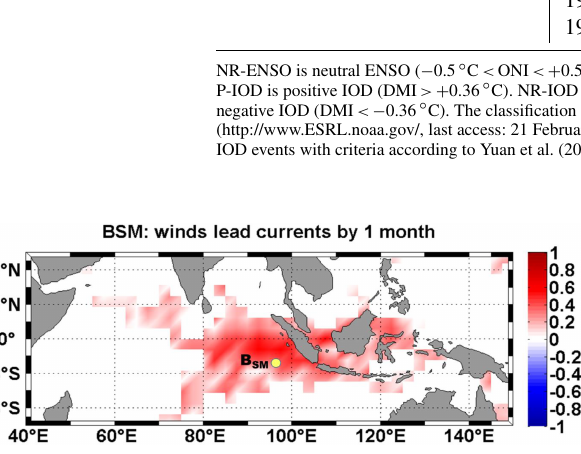
Figure 16. The same as Fig. 15 but at B SM and for interannual signal.